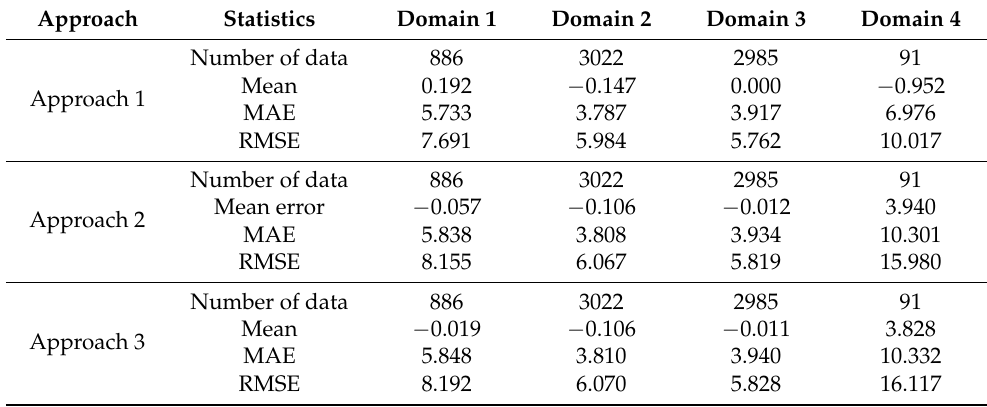
Figure 6. Scatter plots between estimated and true iron grades in D2 and D3 for approach 1. The gravity center (red dot) lies on the identity line, showing that estimates are globally unbiased. Furthermore, the scatter plots fluctuate around the identity line, indicating that the estimates are conditionally unbiased. Table 5. Cross-validation scores for the estimation errors in D1 to D4 (full data